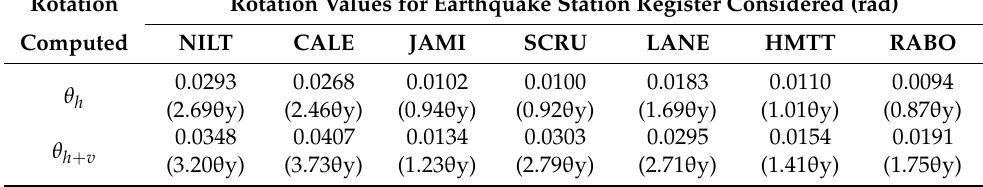
Table 2. Rotations generated by horizontal earthquake components and by horizontal and vertical earthquake components acting together (6-story